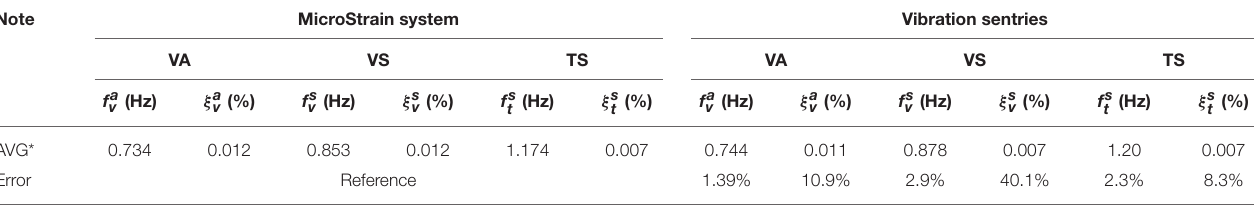
* Average values identified from four sensors where the Vibration Sentries were also installed.